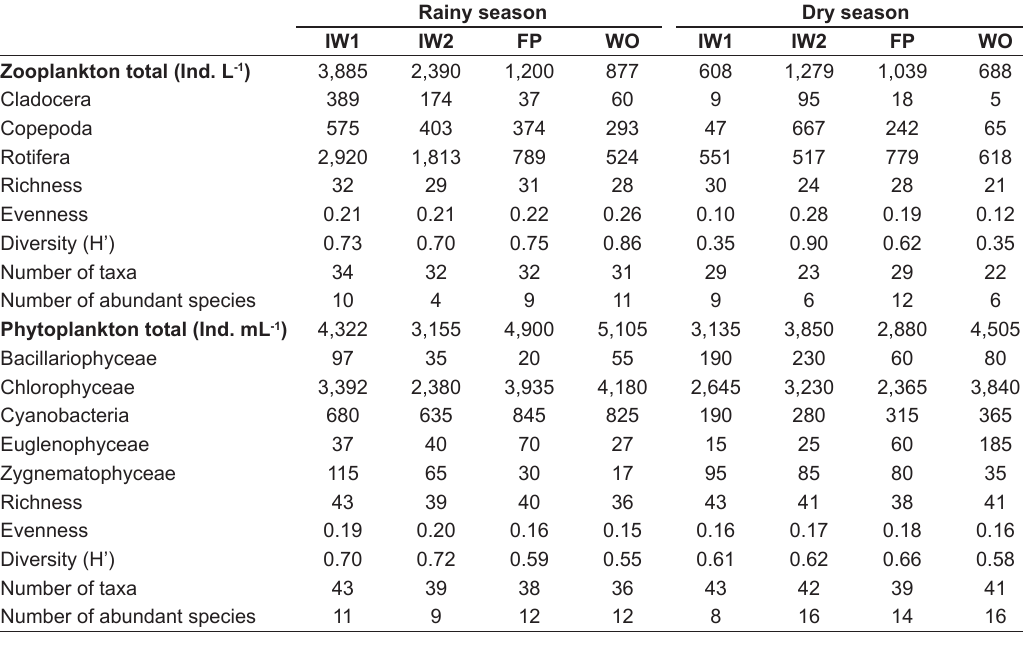
Table 2. Quantitative analyses of phytoplankton and zooplankton communities: density, species richness, evenness, Shannon-Wiener diversity index (H’), total number of taxa and abundant species at sites (IW1 and IW2 = water inlets; FP = deep water site; WO = water outlet) during the rainy and dry seasons.